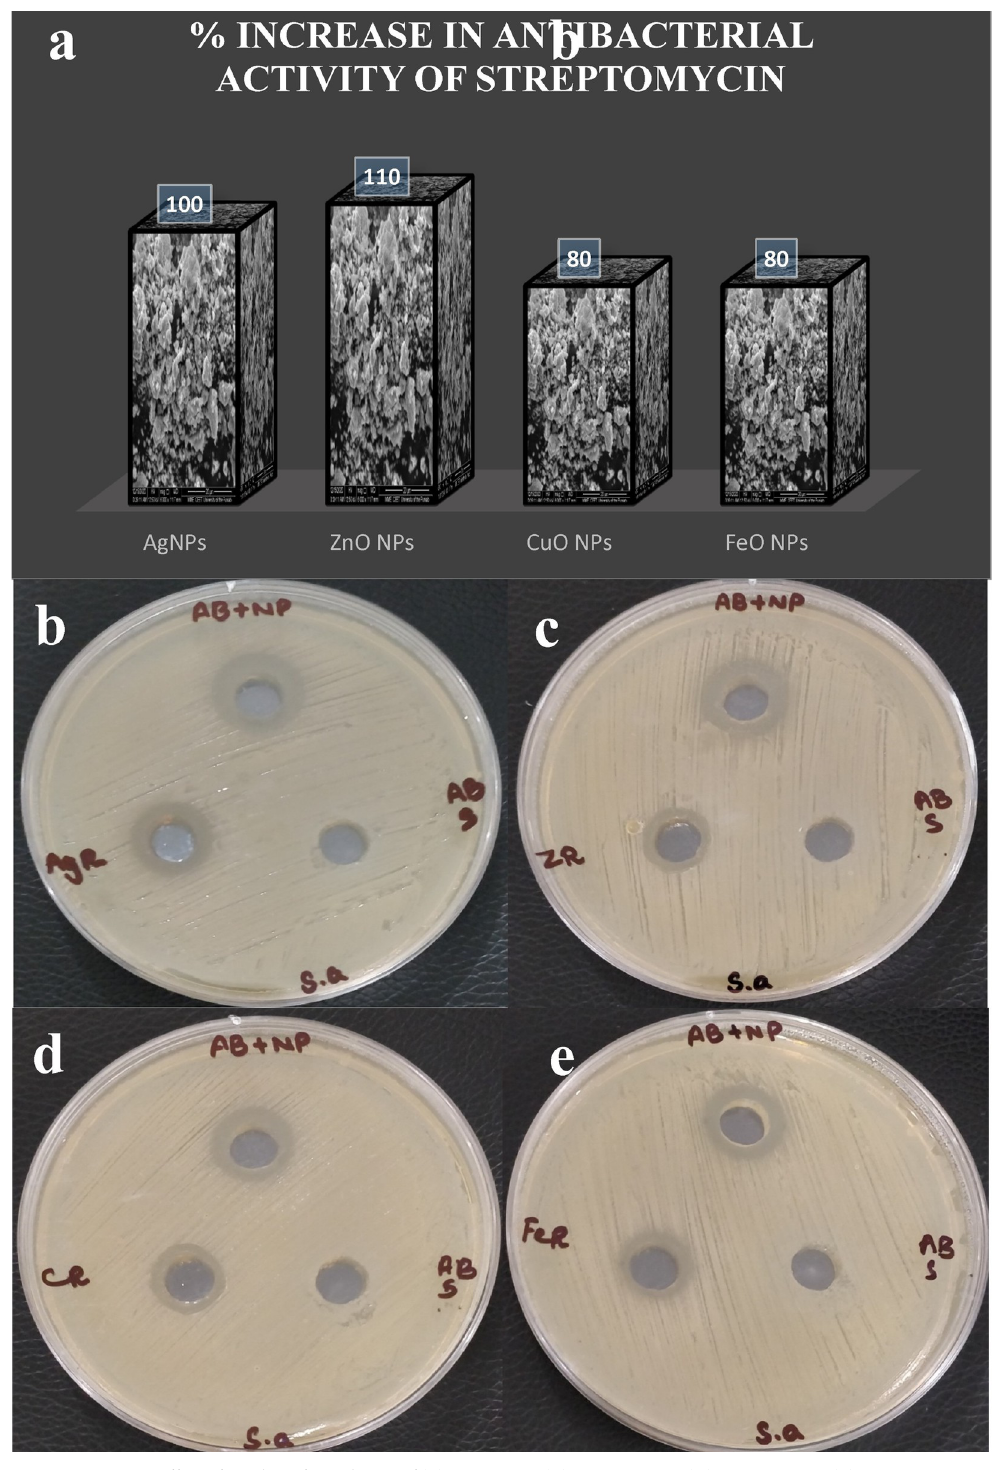
Fig 9. Synergistic effect of combine formulation of (B) AgNPs-Stp (C) ZnO NPs-Stp (D) CuO NPs-Stp (E) FeO NPs-Stp against S . aureus .